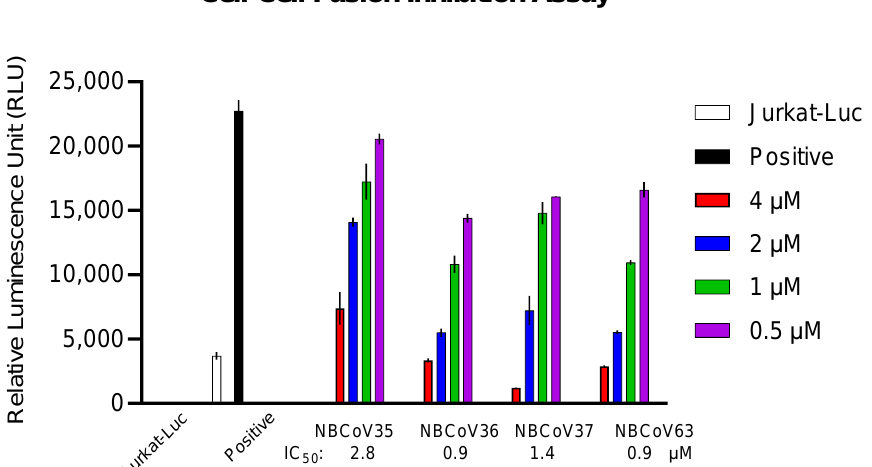
Figure 1. SARS-CoV-2-mediated cell-to-cell fusion inhibition assay. Jurkat cells expressing the luciferase gene and the SARS-CoV-2 full spike wild-type gene from Wuhan-Hu-1 isolate were used as donor cells and the 293T/ACE2 as acceptor cells. Positive represents 293T/ACE2 cells cocultured with Jurkat cells in the absence of NBCoVs. Jurkat-Luc represents 293T/ACE2 cells cocultured with Jurkat cells expressing the luciferase gene only in the absence of NBCoVs. Columns represent the means plus/minus standard deviations (n = 2–4).